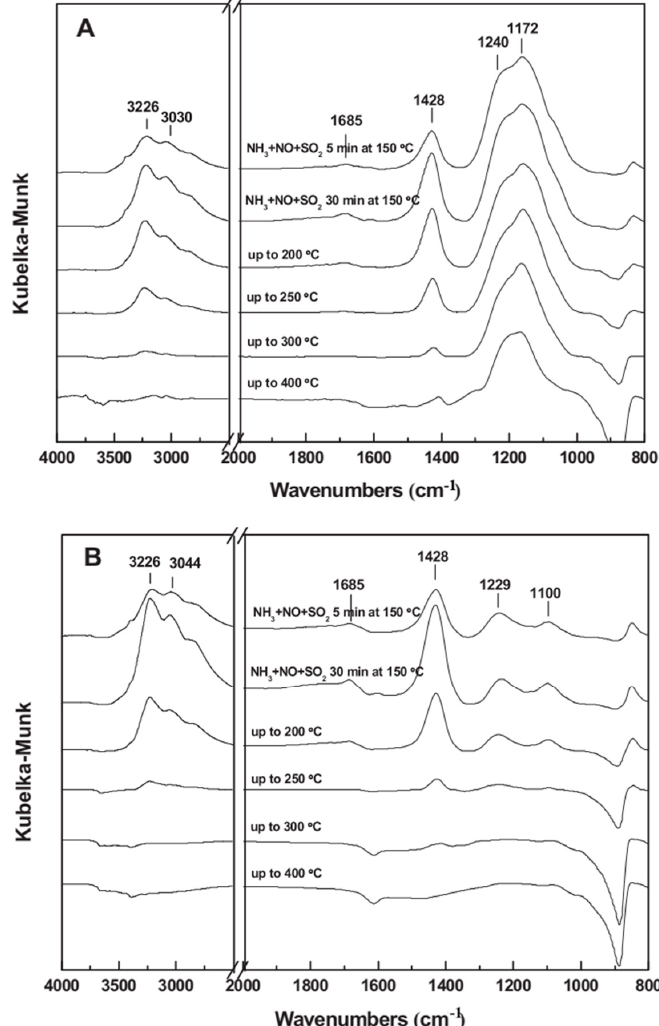
Figure 29. DRIFT spectra of Mn/TiO 2 ( A ) and Mn-Ce/TiO 2 ( B ) exposed to 800 ppm. NH 3 + 800 ppm NO + 100 ppm SO 2 in the presence of O 2 for various times at 150 °C. Subsequently, the atmosphere was switched to only He and the temperature was escalated to 400 °C [18].